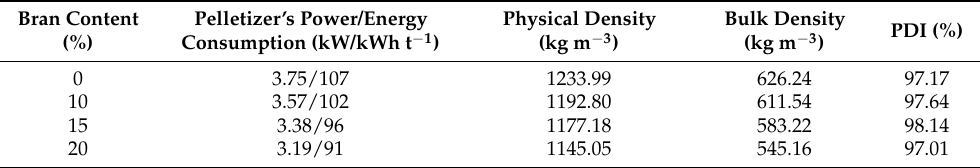
Table 5. The effect of rye bran addition on the pelletization process of sage waste biomass and the quality of the obtained